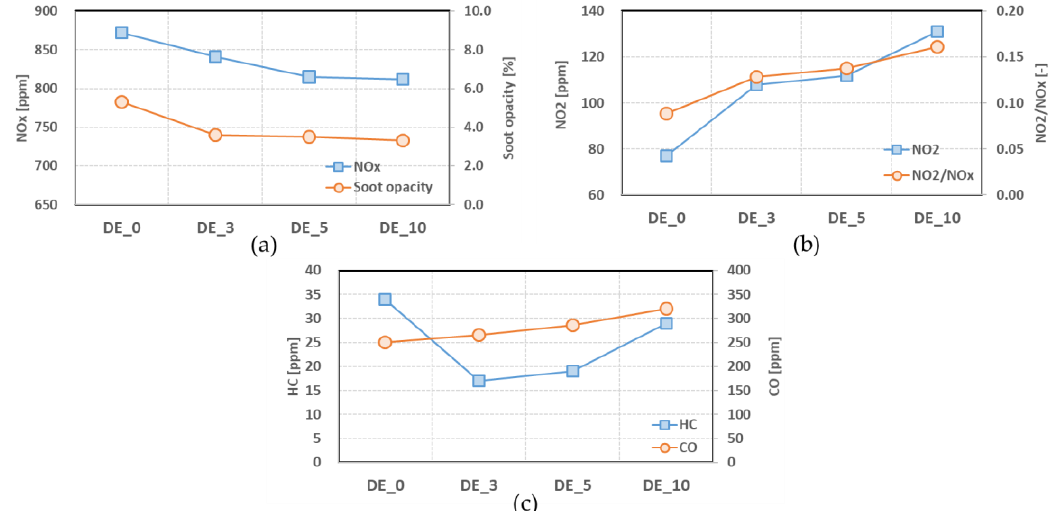
/ NOx, and ( c ) HC and